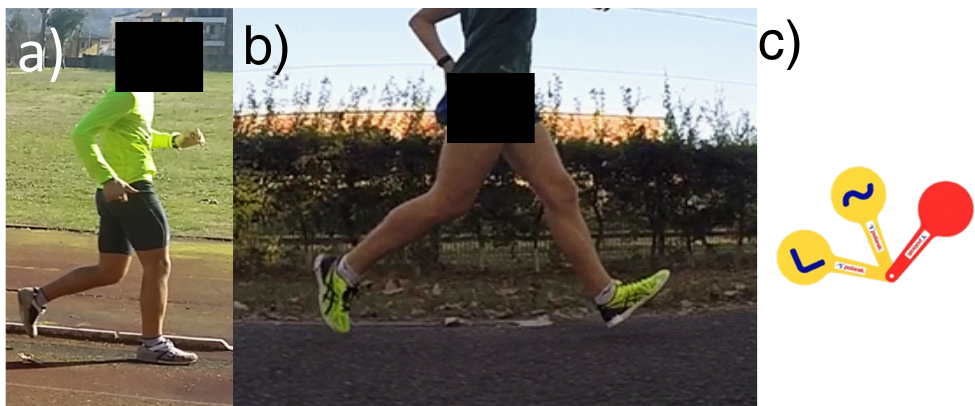
Figure 1. Infringements in race walking: ( a ) athlete in bent knee infringement (with a flexion of the knee before the vertical upright position) and ( b ) athlete in LOGC infringement; ( c ) yellow paddles with the two symbols associated with the two infringements (“ < ”: bent knee; “ paddle (associated with the disqualification of the